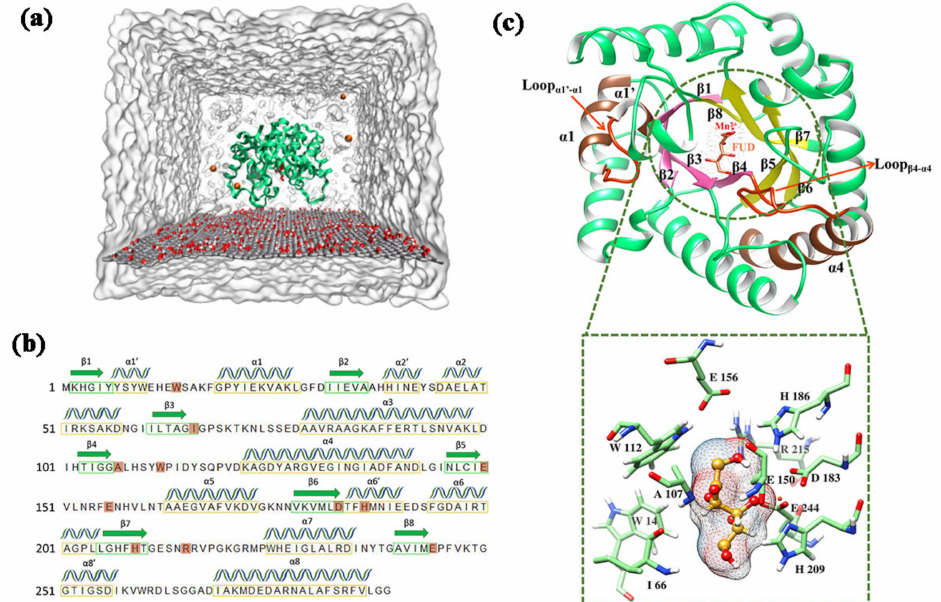
Figure 1. General overview of the initial structure. ( a ) MD simulation box of GO and DPEase- FUD complex with water (the orientation of complex is randomly selected); ( b ) secondary structural elements of DPEase, the helices, and β -strands are displayed in different symbols. Active site residues highlighted in orange; ( c ) molecular architecture of DPEase-FUD and the detailed close-up of the residues interacting with